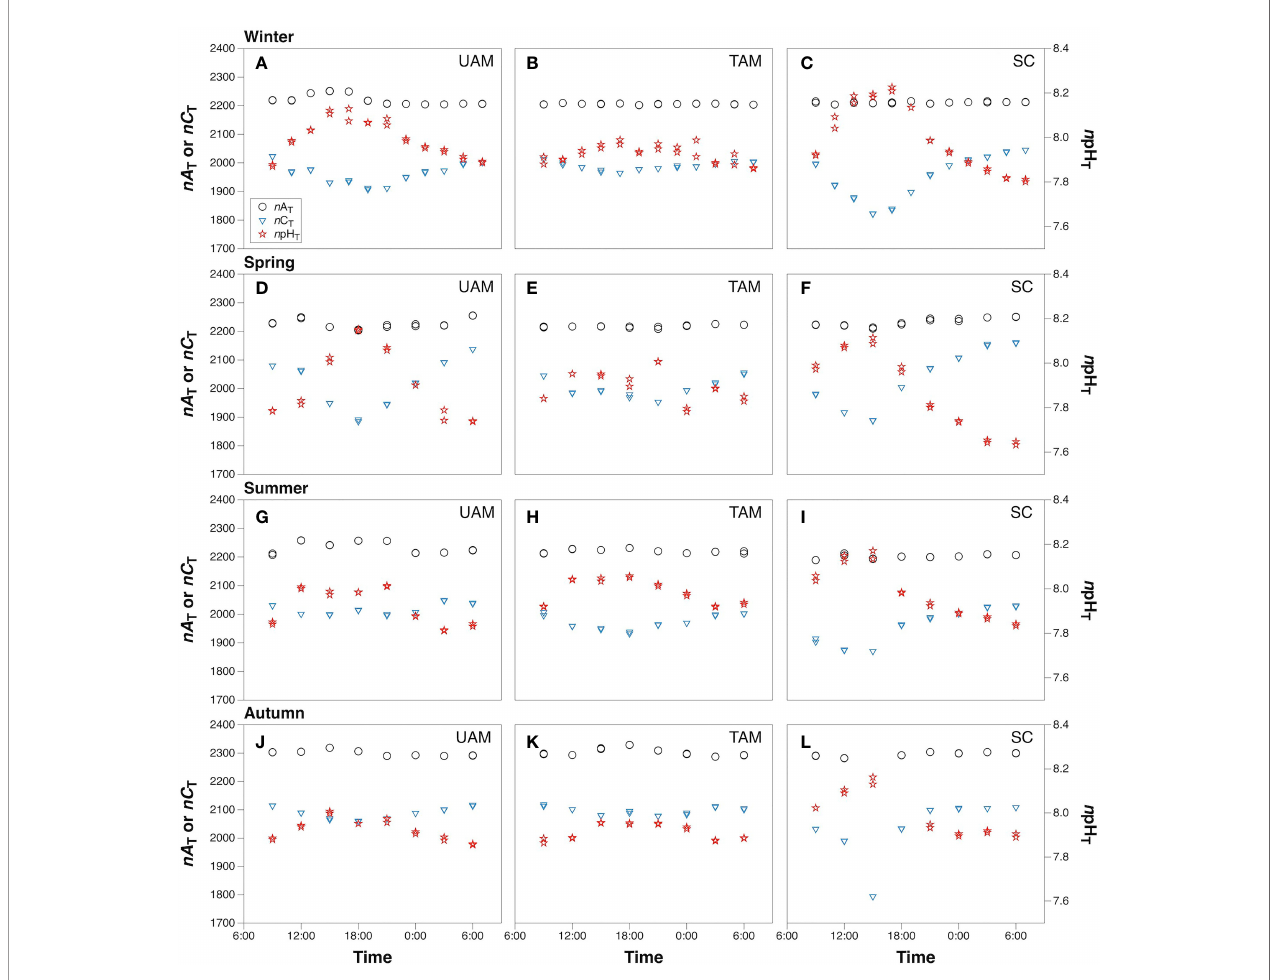
FIGURE 2 | The diel variation of salinity normalized total alkalinity ( nA T , µmol kg -1 ), salinity normalized total inorganic carbon ( nC T , µmol kg -1 ) and temperature normalized pH total scale ( n pH T ) at three sites with different macroalgal habitats (UAM, ulvoid algal mat; TAM, turf algal mat; SC, coexisting Sargassum horneri and crustose coralline algae) in winter (A – C) , spring (D – F) , summer (G – I) and autumn (J – L) . Black circles represent values of nA T , black triangles represent values of nC T , and red stars represent values of n pH T .